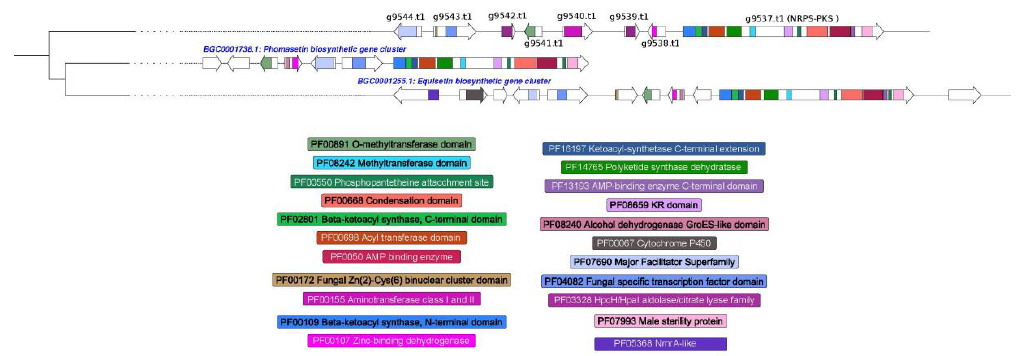
Figure 6. Hybrid NRPS-PKS genes in T. lixii MUT3171: Graphical representation of a hybrid NRPS-PKS gene cluster found in T. lixii MUT3171 showing similarities with equisetin and phomasetin biosynthetic gene clusters, as provided by the MIBig repository. For each gene cluster, the genes and their functional domains are reported. Only domains found in T. lixii MUT3171 genes were